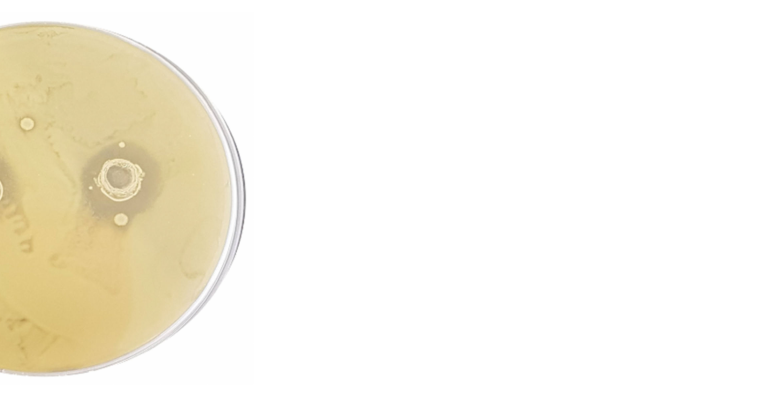
Figure 3. Inhibition zones due to the activity of Leuconostoc citreum UMCC 3011 against Escherichia coli ATCC 43888, observed by a dual plate agar